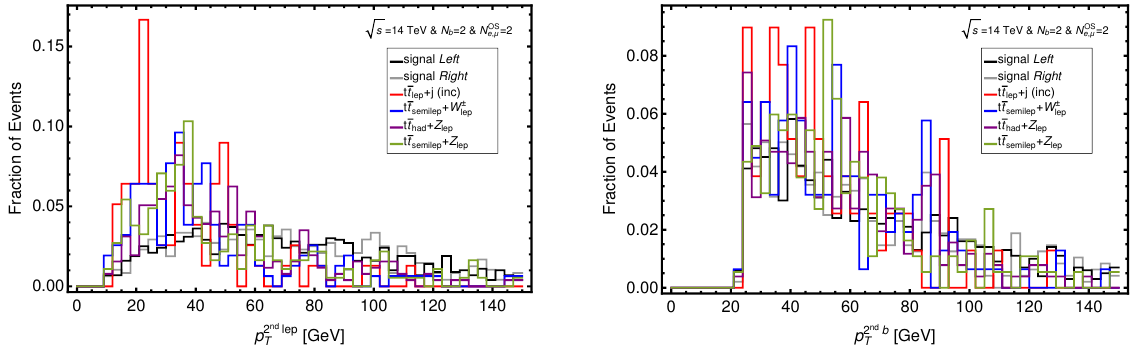
nd lep ( left panel) T